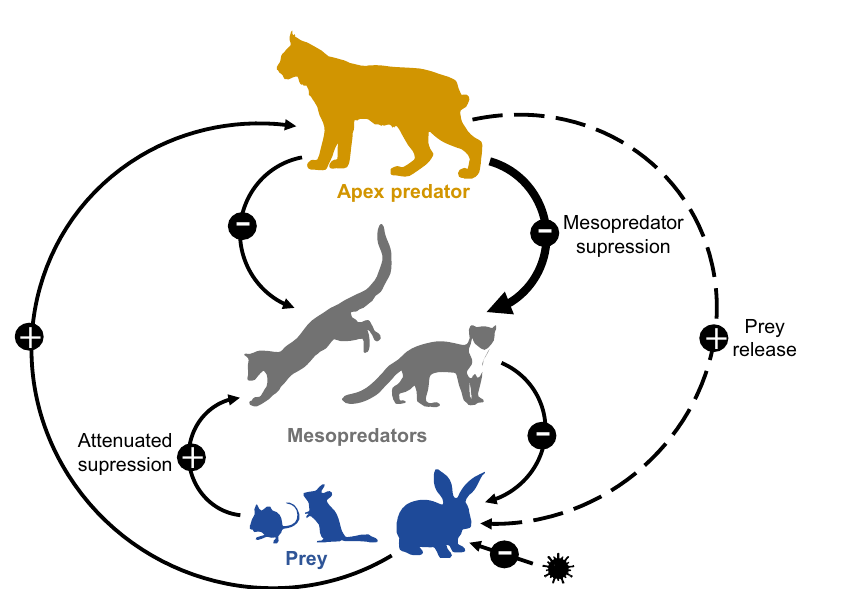
Figure 7. Direct (solid lines) and indirect trophic interactions (dashed lines) in the Mediterranean forest ecosystem. Trophic levels of the network are linked by top-down (descendent arrows) and bottom-up (ascendant arrows) forces which regulates the trophic web. Plus and minus symbols represent a positive or negative effect, respectively, and width of line indicates the relative strength of the interaction. Epizootic diseases (virus silhouette) determine the distribution of the European rabbit ( O. cuniculus ), the main prey of the Iberian lynx ( L. pardinus ) which is the apex predator in this ecosystem. Lynx controls mesopredator abundances and releases prey (rodents and rabbits) from their predation pressure. However, the suppression of the common genet ( G. genetta ) is lower compared to suppression of the stone marten ( M.s foina ) possibly attenuated due to its more specialized diet in